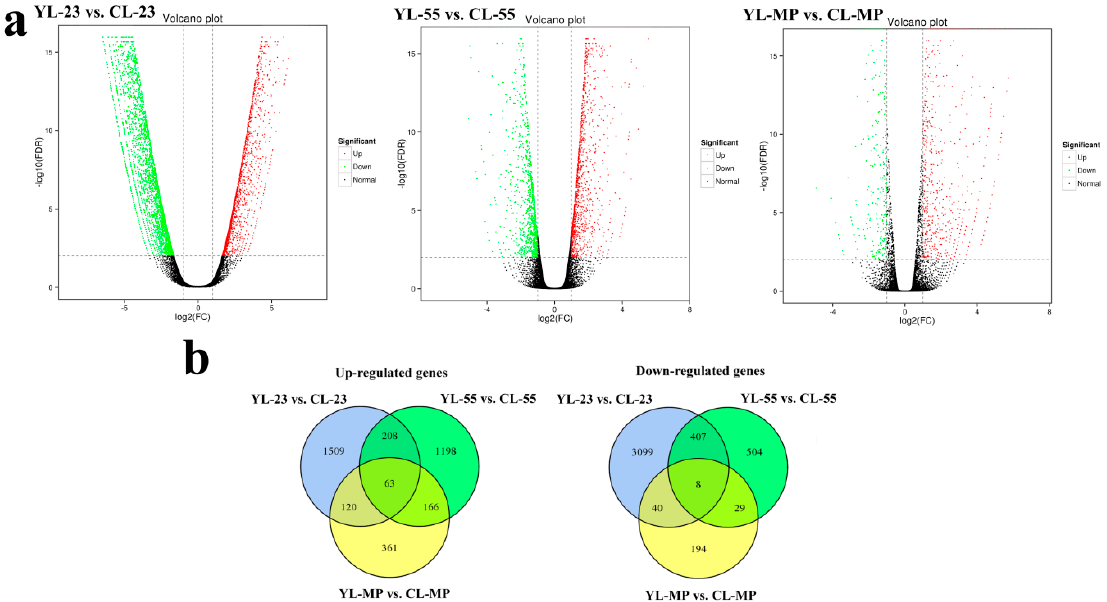
Figure 4. Statistics on the number of di ff erentially expressed genes: ( a ) Volcano plot of di ff erentially expressed genes (DEGs) between di ff erent samples; ( b ) Venn diagram of DEGs between di ff erent samples. Up-regulated genes in A_vs._B: genes whose expression level in sample B are higher than that in sample A; otherwise they are down-regulated genes.